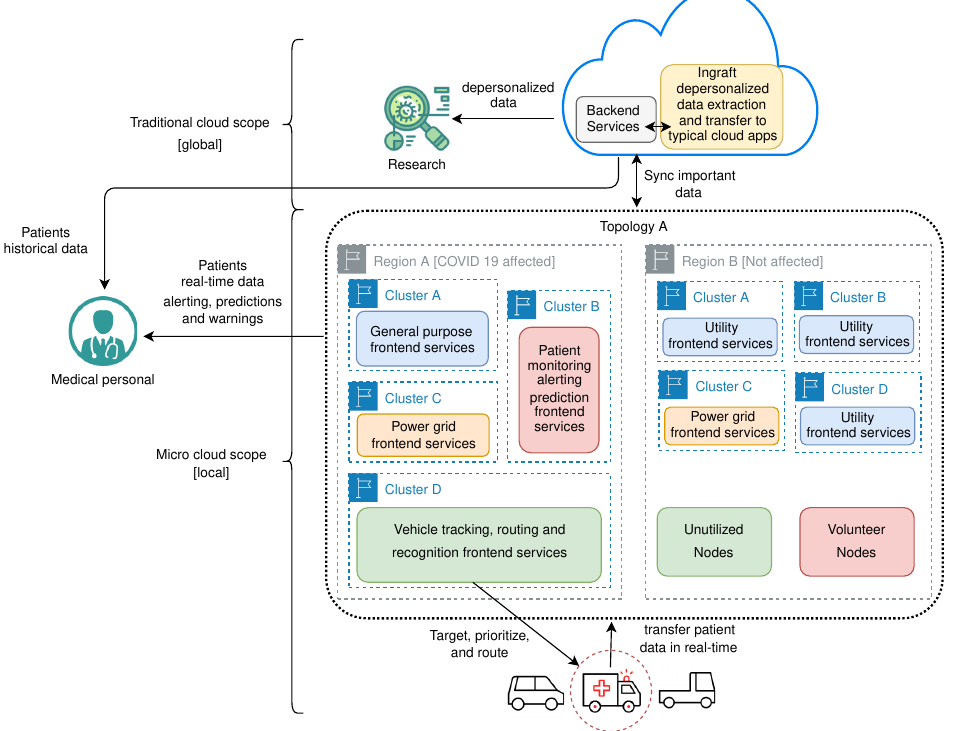
Figure 12. Conceptual architecture model for COVID-19 area traffic control